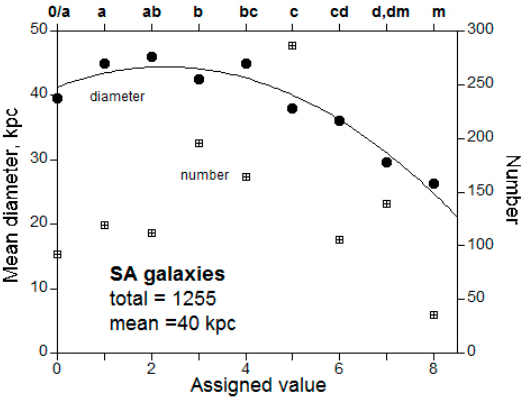
Figure 6. Dependence of the mean diameter on arm type for SA galaxies. Type SA0/a is shown at the origin. Squares indicate the number of galaxies in each category (upper x ‐ axis) in the NED database [42], which provided the necessary data for 1255 SA galaxies. The lower x ‐ axis shows integer values assigned to each type for facilitated plotting. On this diagram, galactic evolution progresses left to